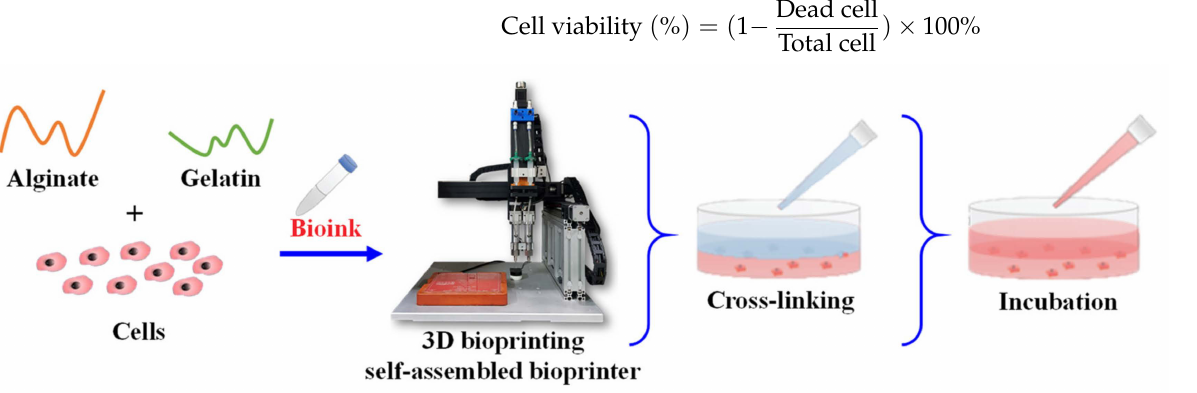
Figure 3. A schematic diagram showing the experimental setup used for evaluation of the post- printing cell viability of the optimal